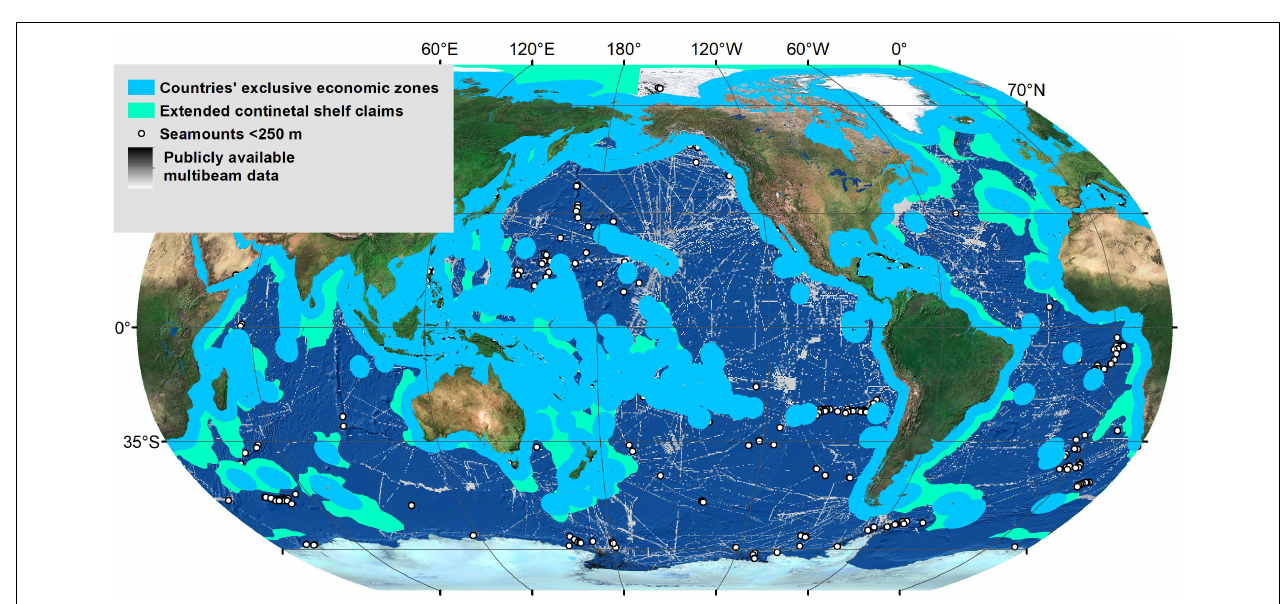
FIGURE 4 | Diver captures video of coral reef habitat on the summit of Gray Feather Bank at a depth of 25 m. While located within the EEZ of the Federated States of Micronesia, this sunken atoll demonstrates the potential for ABNJ coral reef ecosystems to exist in nearby open-ocean environments where benthic habitat at suitable depths exists (Photo courtesy of B. Cranston).